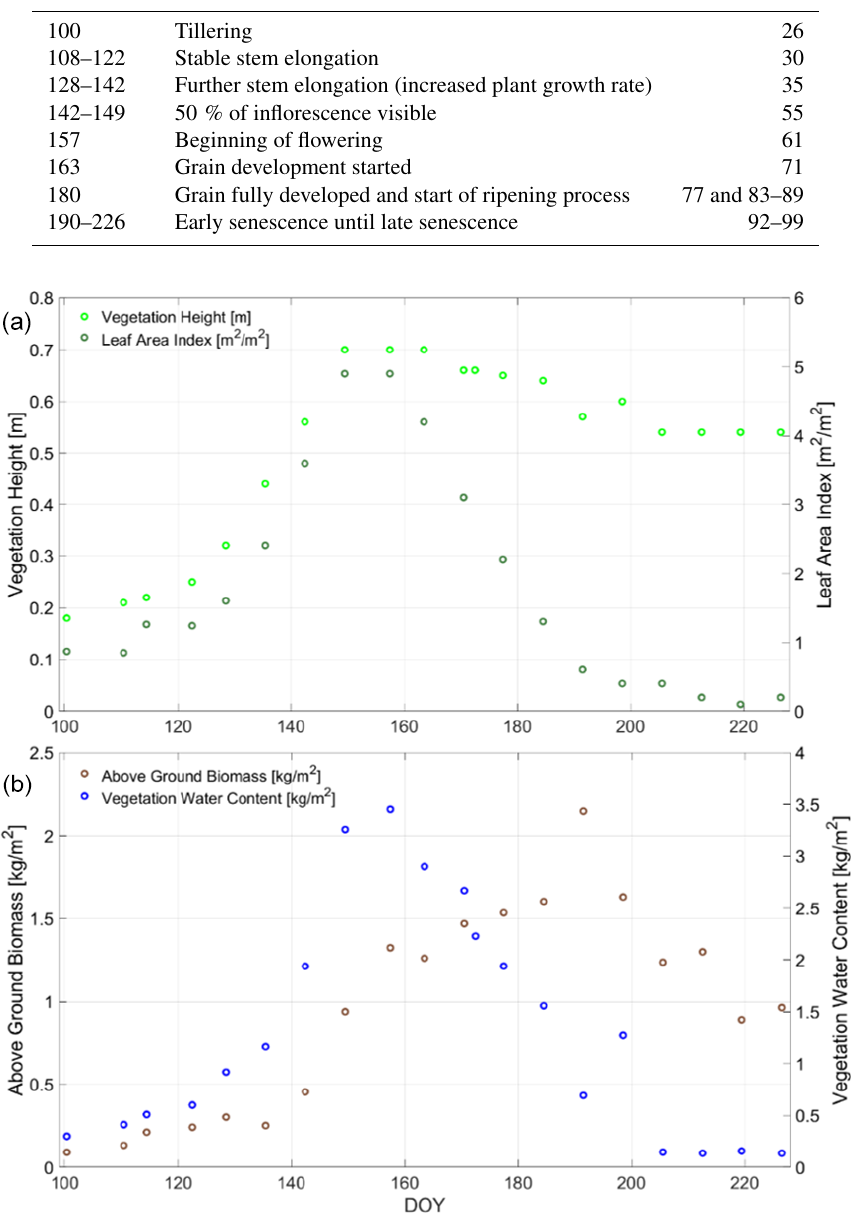
Figure 1. In situ measurements of the wheat field along growing season for days of year (DOY) in 2017 at the Selhausen field laboratory, Germany: Vegetation height [m] and leaf area index (LAI) [m 2 m − 2 ] (a) ; above ground biomass (AGB) [kgm − 2 ] and vegetation water content (VWC) [kgm − 2 ] (b) (Meyer et al.,